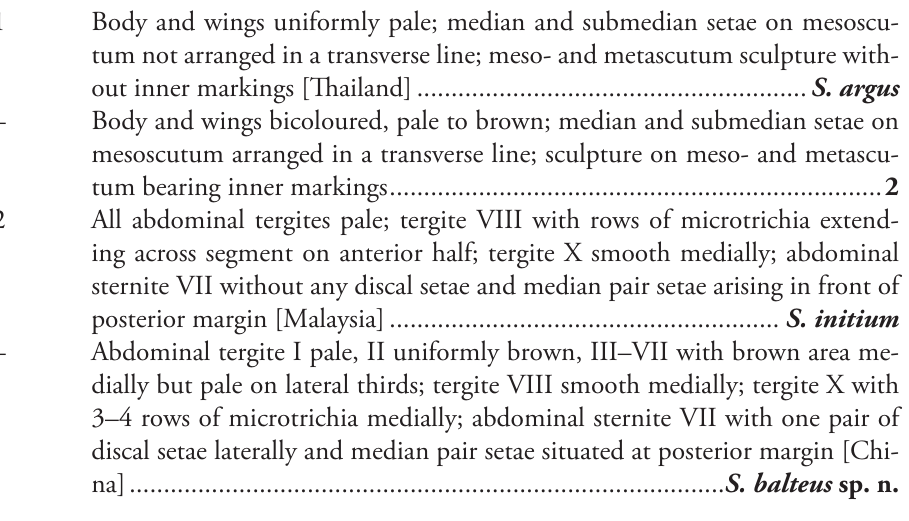
Material examined. Holotype. 1 female: CHINA , Jiangxi province, Jing’an County, Sanzhualun National Forest Park, Luojiaping (29°01'33"N, 115°17'32"E, alt. 630m), collected from young leaves of Loropetalum chinense (Hamamelidaceae), 17.viii.2016, leg. Zhaohong